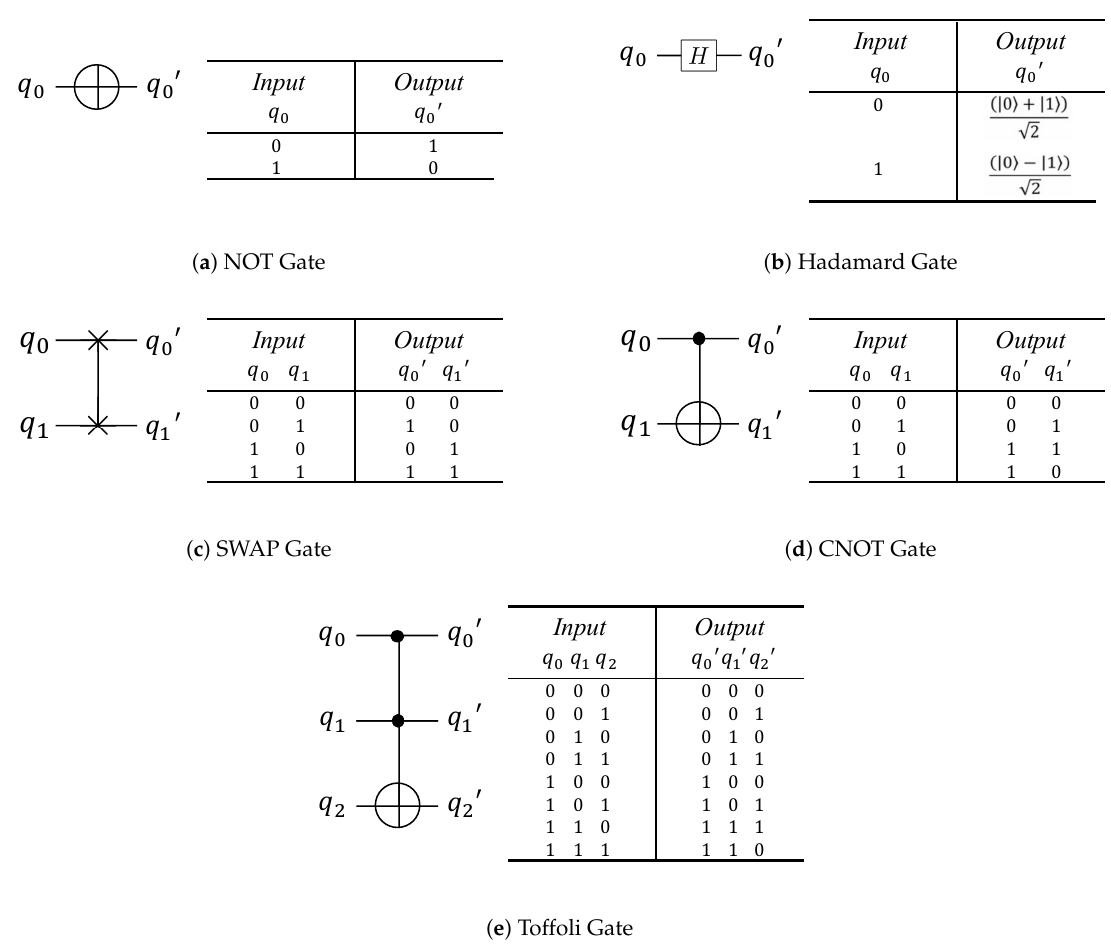
Figure 2. The symbols in quantum circuits and truth tables of the five quantum